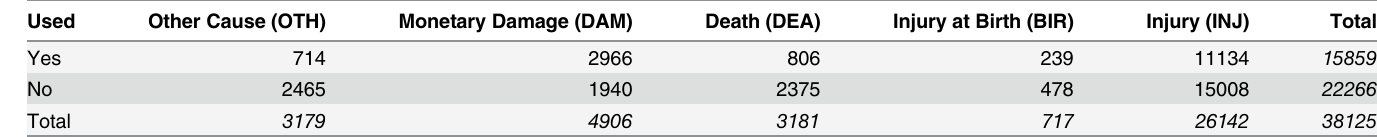
Table 2. Number of claims per alleged cause of claim, as used (Yes vs. No) in the analysis of the monetary amounts. Used Other Cause (OTH)